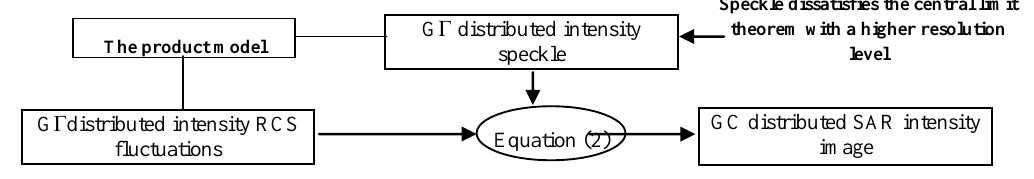
Figure 6. Statistical models when the speckle component dissatisfies the central limit